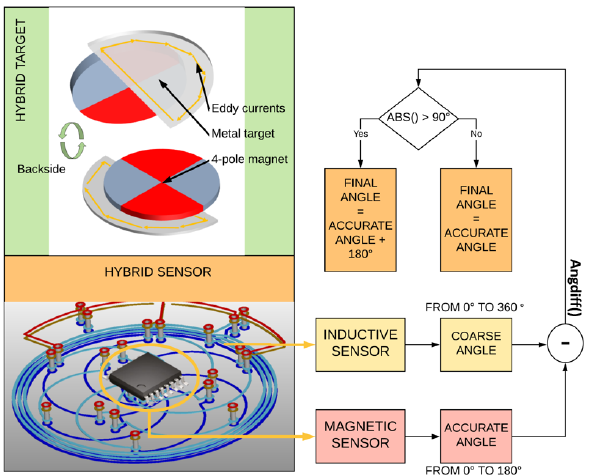
Figure 4. Concept diagram of the hybrid sensor and target. The hybrid sensor consists of a magnetic sensor providing an accurate angle in the 180 ◦ range, an inductive sensor providing a coarse angle and an algorithm combining both angles into a final angle. The target combines a metallic half-moon disk and a 4-pole ferrite magnet. Refer to Equation (1) for a mathematical description of the hybrid angle